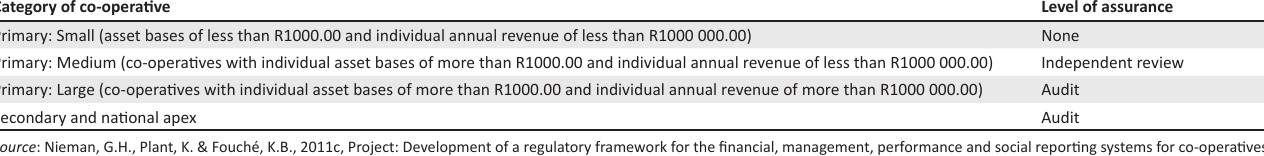
TABLE 2: Level of assurance by category of co-operative. Category of co-operative Level of